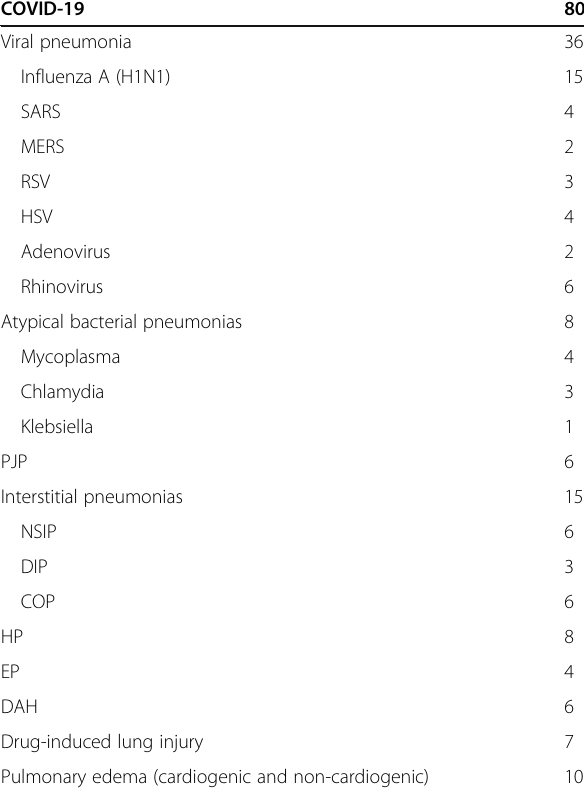
Table 1 Etiology of ground-glass opacities in study groups